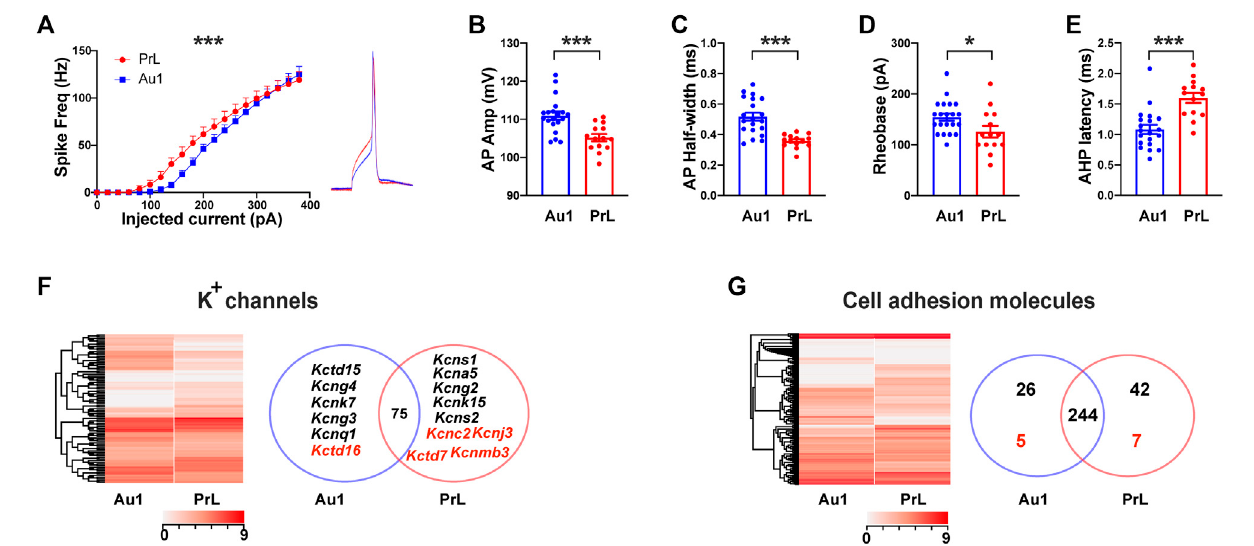
FIGURE 2 | Electrophysiological properties and gene expression pro fi les in PV-neurons in Au1 and PrL-PFC. (A) A signi fi cantly higher intrinsic excitability in PV- neurons in the PrL-PFC than in those in Au1. (Right) Representative single spike in Au1 and PrL-PFC. (B) A signi fi cantly lower amplitude of action potentials in PrL-PFC PV-neurons compared to Au1. (C) A signi fi cantly lower half-width of action potentials in PrL-PFC PV-neurons compared to Au1. (D) A signi fi cantly lower rheobase of actionpotentialsinPrL-PFCPV-neuronscompared toAu1. (E) Asigni fi cantlyhigherAHPlatencyofactionpotentialsinPrL-PFCPV-neuronscomparedtoAu1. (F) Comparisons ofK + channelsgeneexpressionbetweenAu1and PrL-PFC. (Left) Heatmap showingexpression ofalldetected K + channelsubunitsinAu1and PrL-PFC. (Right) A Venn diagram showing Au1-speci fi c or PrL-PFC-speci fi c genes (names in black), and genes showed signi fi cantly higher expression in either brain region (names in red). Seventy- fi ve genes not differentially expressed in Au1 and PrL-PFC. (G) Expression of cell adhesion molecules in Au1 and PrL-PFC. (Left) Heatmap showing expression of all detected CAMs. (Right) A Venn diagram showing the numbers of Au1-speci fi c or PrL-speci fi c CAMs (numbers in black), and genes showed signi fi cantly higher expression in either brain region (numbers in red). There are 244 genes expressed in both brain regions with no difference in expression level. For electrophysiology, N (cid:2) 19 cells/3 mice for Au1 group, N (cid:2) 14 cells/3 mice for PrL-PFC group. In all heatmaps, the redder the color the higher the expression level. Standardized method: log(value + 1). * p < 0.05. *** p <